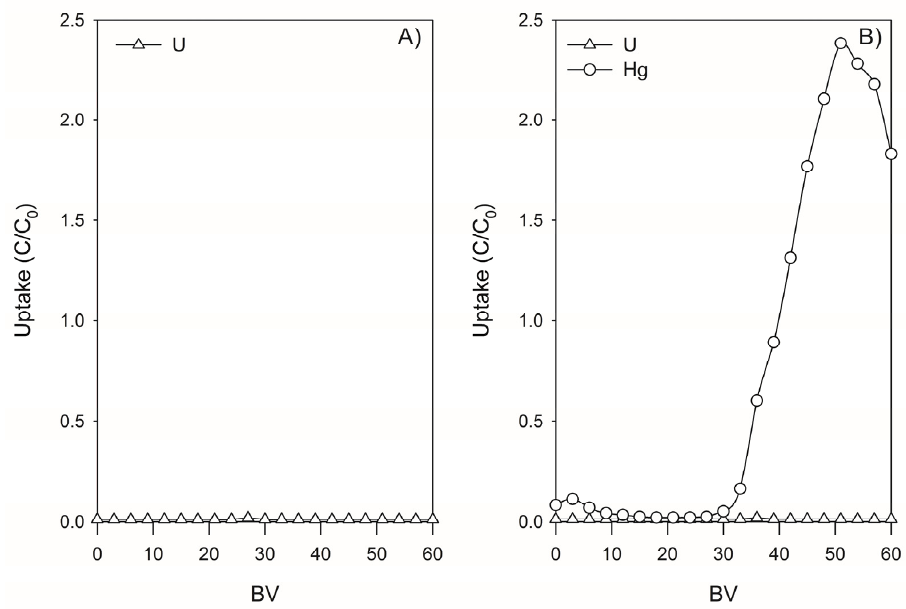
Figure 4. Chromatographic extraction profile of uranium and mercury on Lewatit TP260 using ( A ) SCRWL’-U and ( B ) SCRWL’-U-Hg; BV = 12 mL; Flow rate = 3 BV/h. ( A ) SCRWL’-U and ( B ) SCRWL’-U-Hg; BV = 12 mL; Flow rate = 3 BV/h.